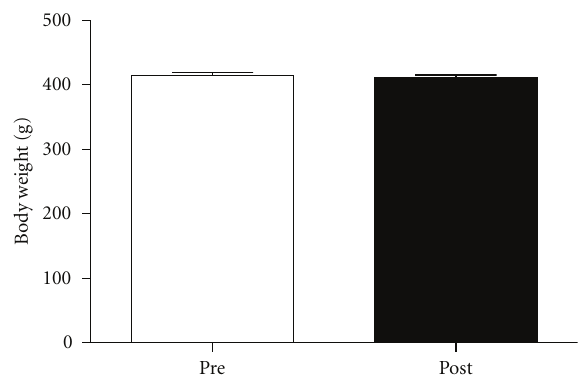
Figure 3: Body weight before (Pre) and at the end (Post) of the adaptation phases. Not significantly di ff erent ( P > 0 . 05).